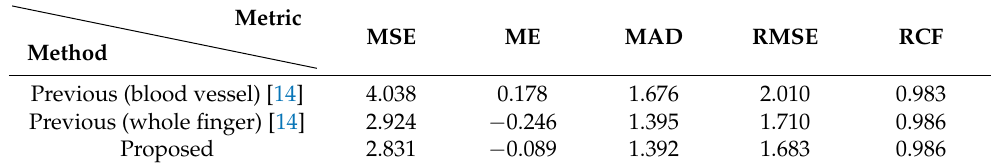
Table 7. SpO estimation performance comparison between this study and the previous study. 2